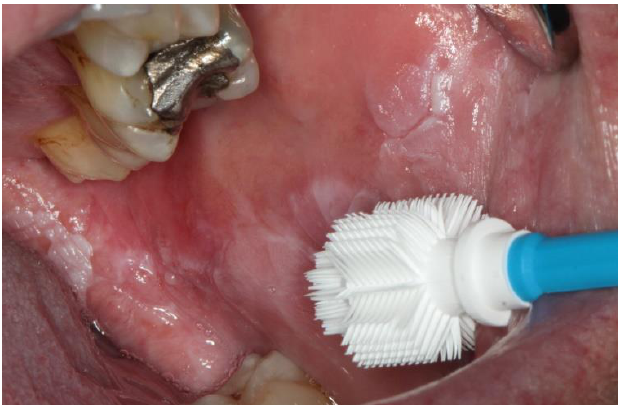
Figure 1. Cell collector Orcellex brush in front of a leukoplakia on the buccal mucosa.